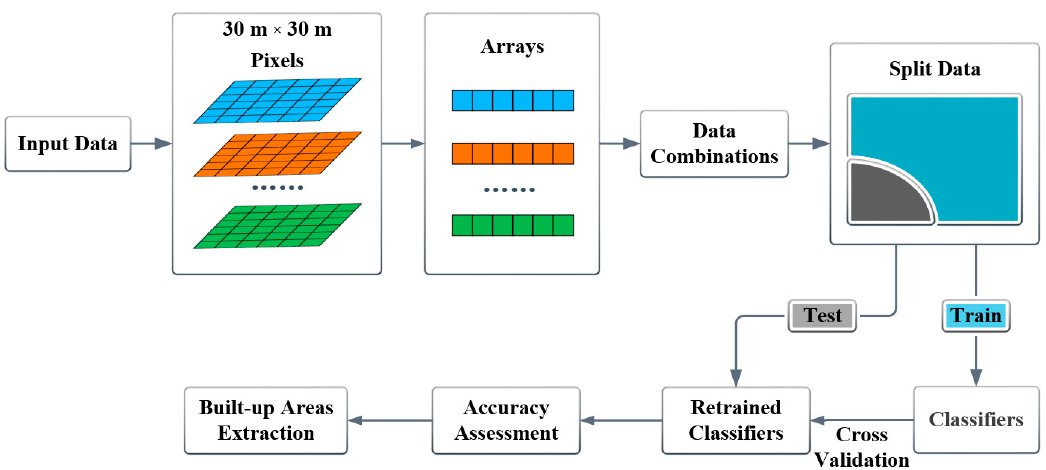
Figure 1. The framework of the built-up area intelligent classification (BAIC) developed in this study. Table 1. The four types of classification results.